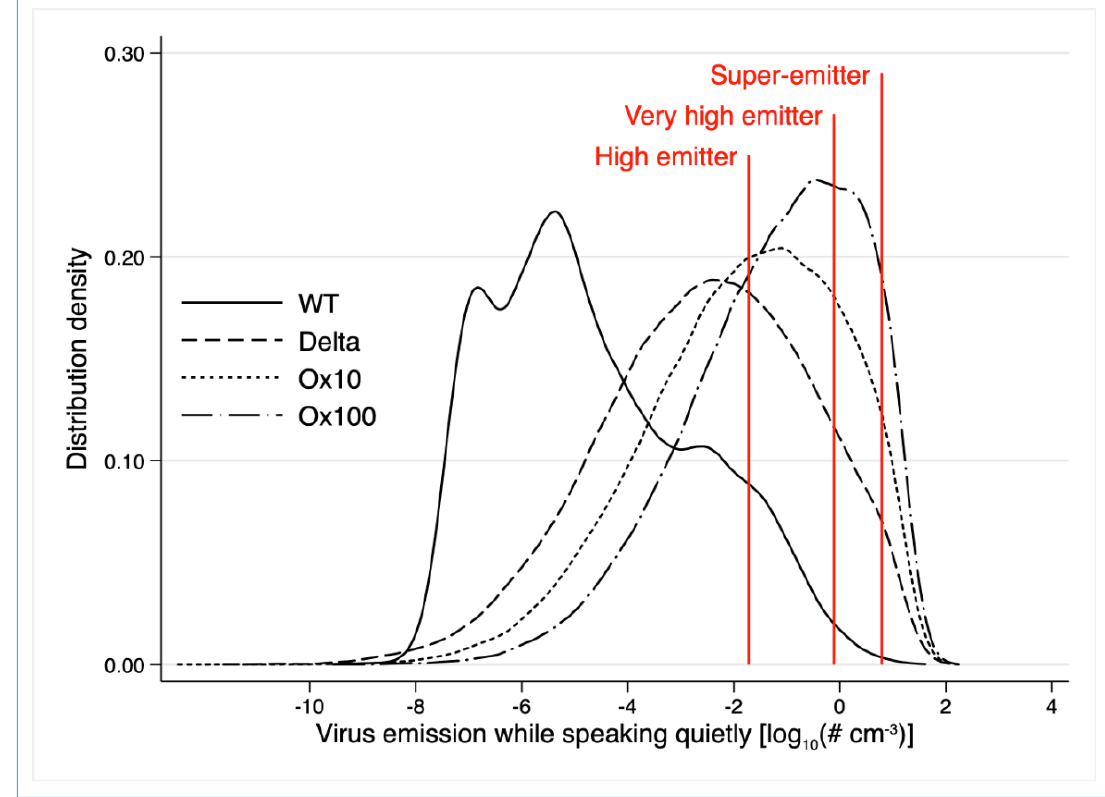
Figure 1: Distribution of viral emissions in populations infected with the WT, the Delta and the Omicron variants when speaking at low vocal in- tensity. Red lines indicate the high emitter (90 th percentile of WT), very high emitter (99 th ) and super-emitter (99.9 th ) thresholds. Ox10 and Ox100 indicate simulations for Omicron assuming 10 times and 100 times higher mean viral loads compared to Delta.